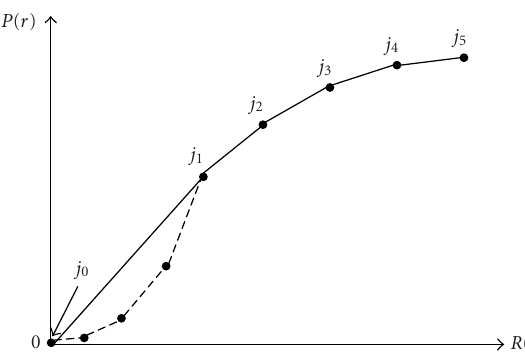
Figure 5: Elements of a convex hull set are the vertices j ... , j { j } which lie on the convex hull of the P ( r ) versus R ( r ) 0 , 1 , 5